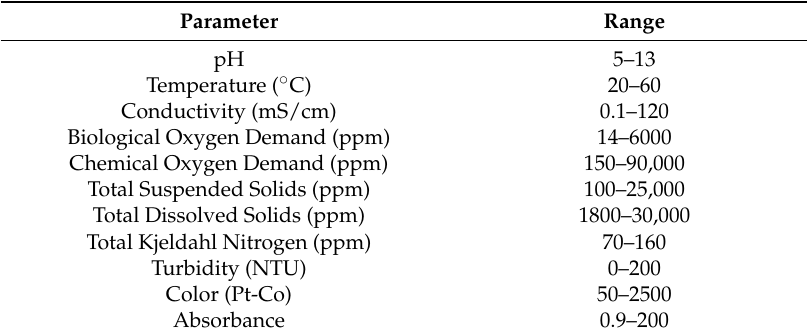
Table 1. Typical Physical chemical composition of textile wastewaters